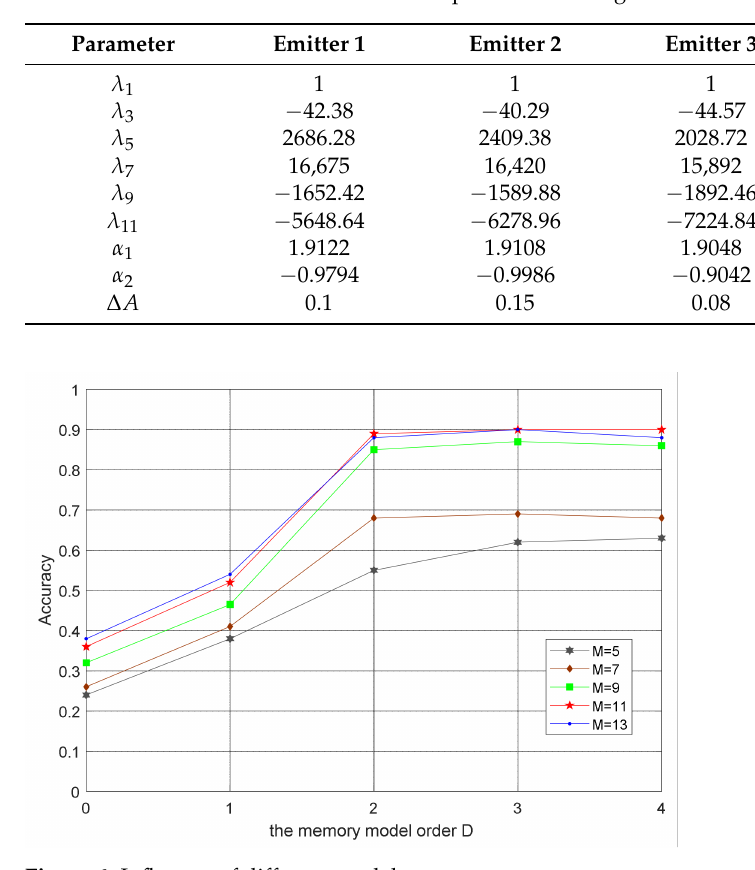
Figure 6. Influence of different model structures on